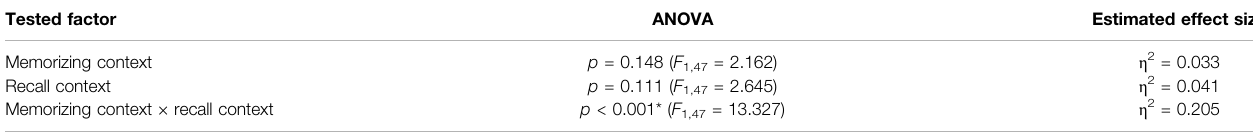
TABLE 5 | Outcomes of a two-way ANOVA test using recall score as dependent variable, with memorizing and recall context-conditions and their interaction ( × ) as model terms ( n (cid:1) 51; sub-sample sizes are reported in Table 4 ; degrees of freedom are one for each factor and 47 for the residuals). Tested factor ANOVA Estimated effect size